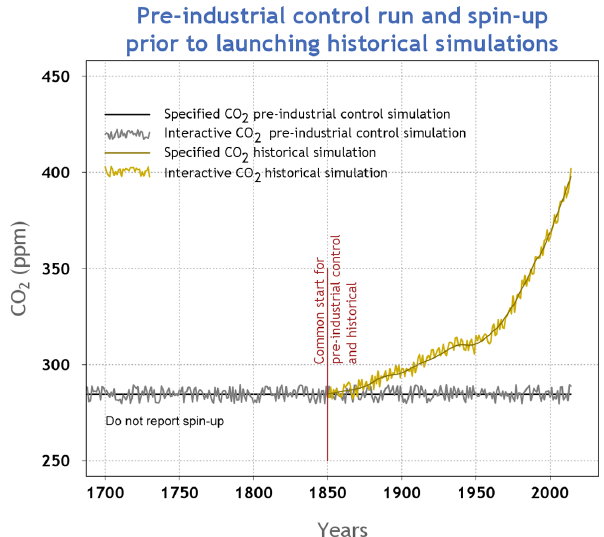
Figure 3. Schematic representation of model spin-up followed by control and historical simulations through 2014. The interactive CO 2 pre-industrial control should ideally have a drift of less than